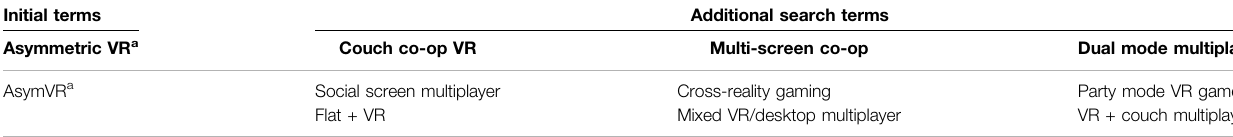
TABLE 2 | Extended keywords or key phrases list, which was used in gathering data from Reddit via